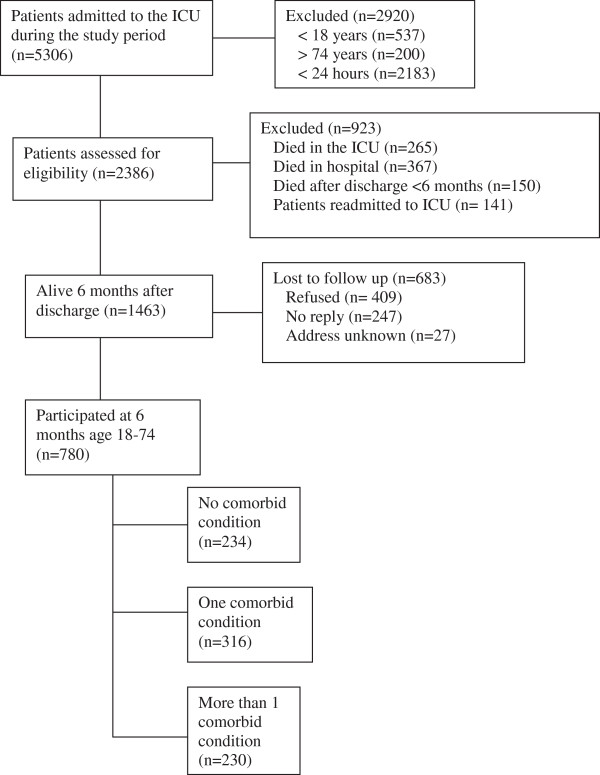
Outline of the protocol of the study.